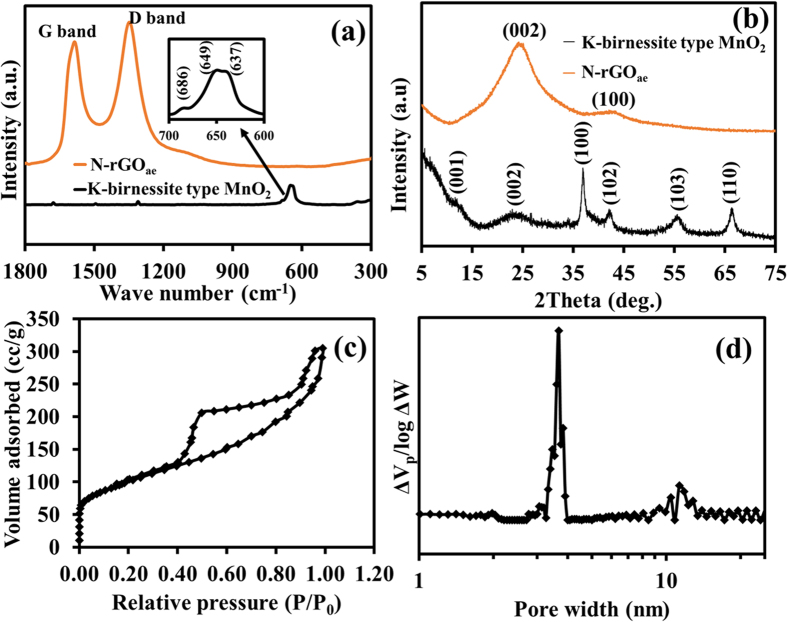
(a) Raman spectra, (b) XRD patterns of MnO2 and N-rGOae and (c) N2 sorption isoterm and pore size distribution of N-rGOae.